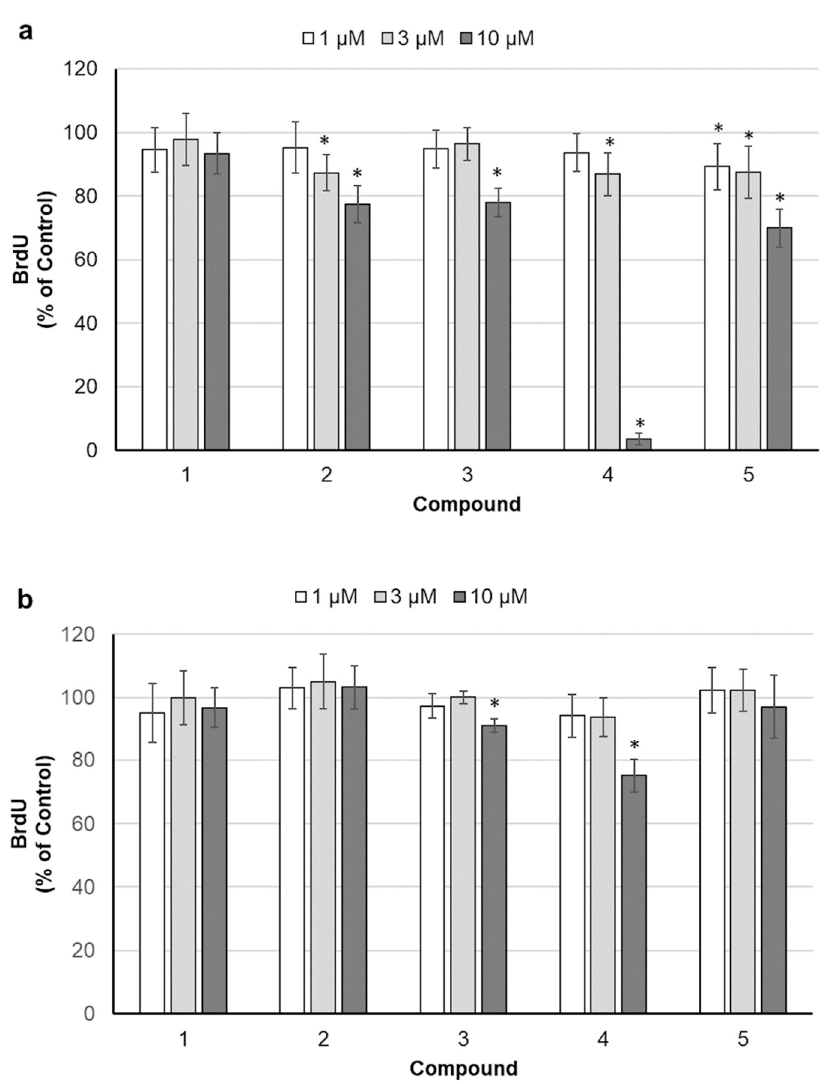
Figure 2. Effect of 24 h exposure to betulin and its derivatives on bromodeoxyuridine (BrdU) incorporation in SK-BR-3 ( a ) and MCF-7 ( b ) cells; the results are shown as mean ± SD; * p < 0.05 compared with control.